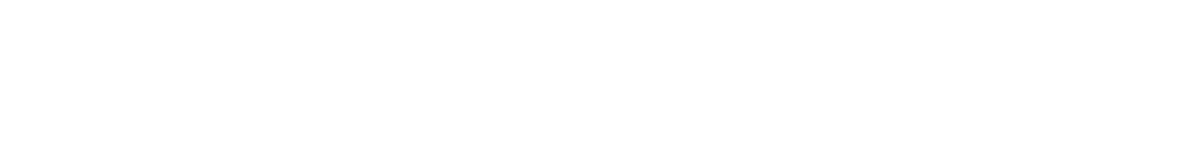
Frontiers in Cell and Developmental Biology |